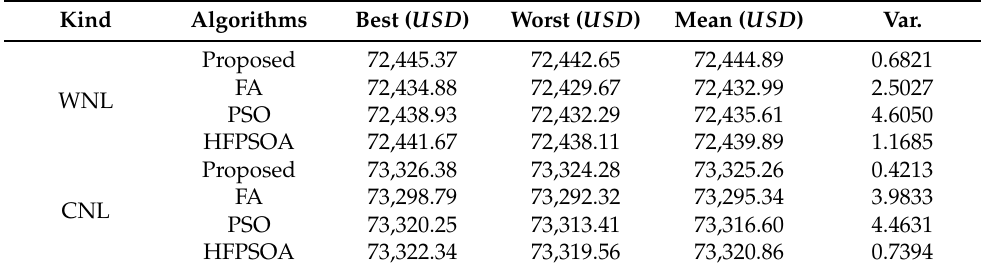
Table 1. Statistical convergence metrics of various algorithms.